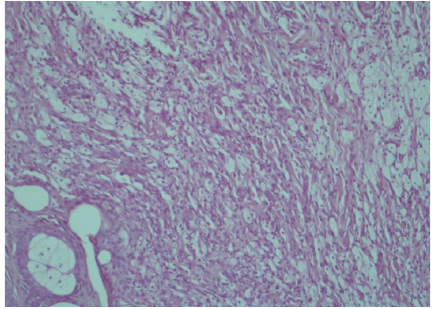
Figure 2: Involvement of flexural regions of neck with papule that confluent to plaque lesion.